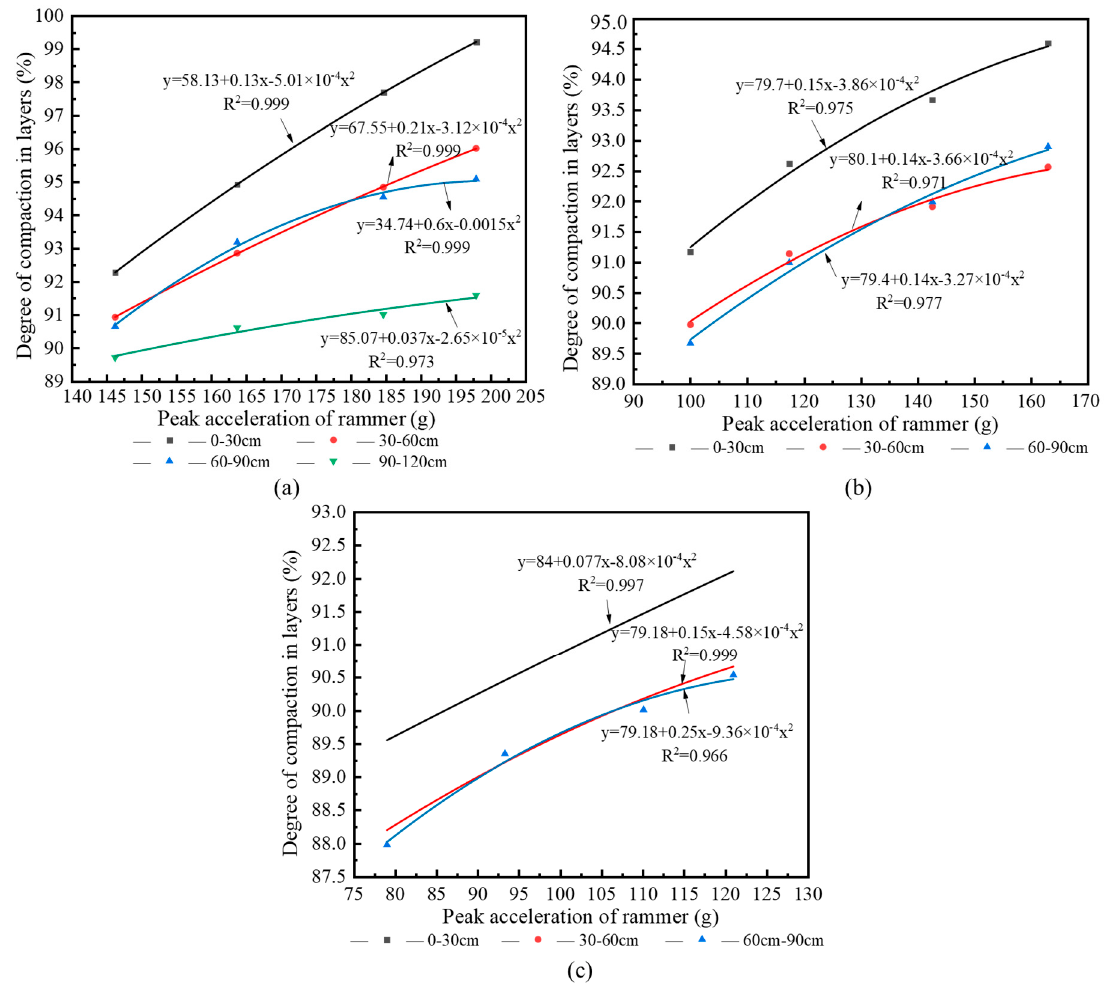
Figure 11. Regression curve of peak acceleration and layered compactness: ( a ) condition 1; ( b ) condition 2; ( c ) condition 3.